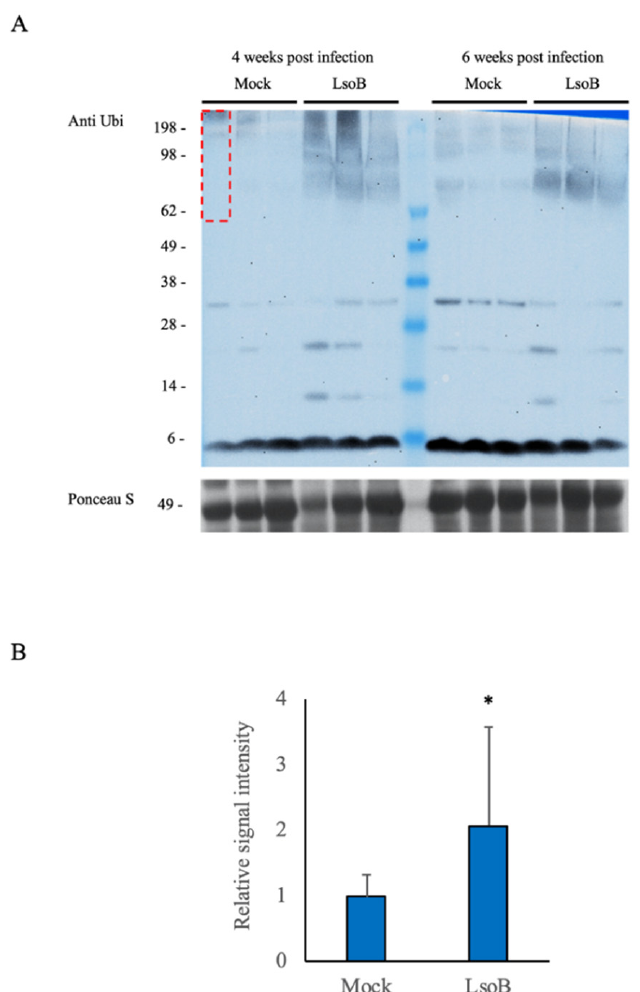
Figure 6. Immunoblot of tomato leaves at 4 weeks and 6 weeks post-LsoB infection. ( A ) Plants were infested with either Lso-free (Mock) or LsoB-infected (LsoB) adult psyllids. The dotted box indicates the range (60–200 kDa) used to quantify the ubiquitin signal intensity in ( B ). Error bars indicate the standard deviation (SD). Asterisk indicates significant difference from Mock group by Student’s t -test ( p < 0.05). The experiment was replicated three times, each with three plants in each group. The Western blot was repeated at least twice per sample, each showing similar results.